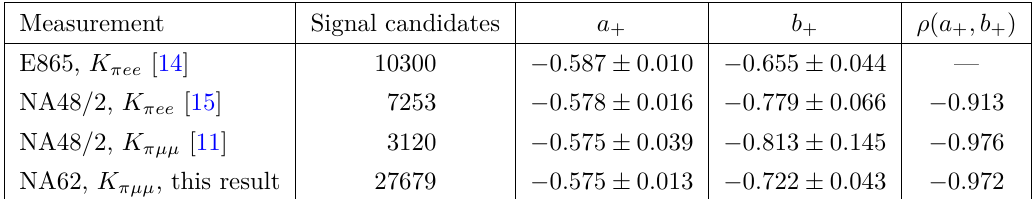
Table 3 . Comparison with the previous measurements of the K ± → π ± ‘ + ‘ − form factor param- eters. The E865 K measurement [14] does not provide the systematic uncertainties, nor the πee correlation coefficient of the form factor